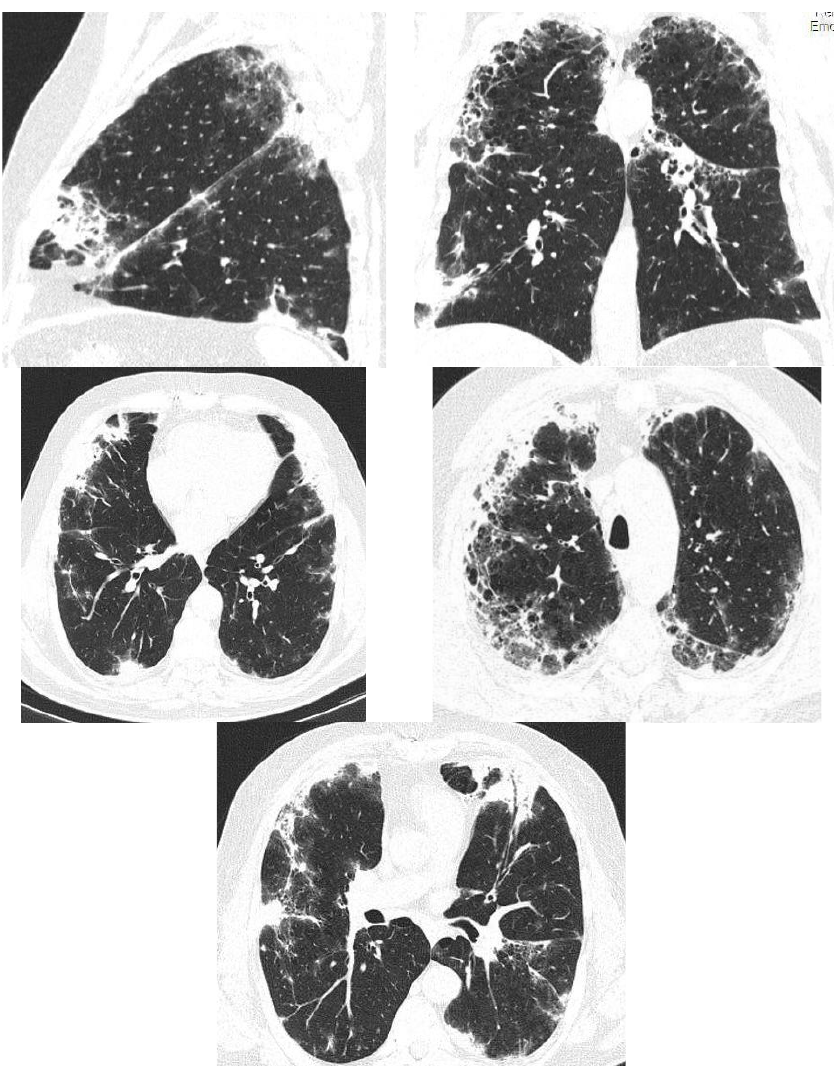
Figure 2. HRCT — July 2019 — Case 1. Subpleural honeycombing, nodular lesions, linear fibrosis, traction bronchiectasis, reticulation and ground glass opacities with associated minimal emphysema. Diffuse pulmonary infiltrates in the inferior half.